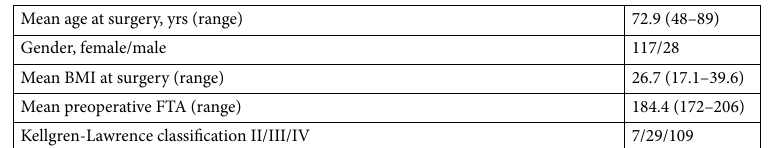
Mean age at surgery, yrs